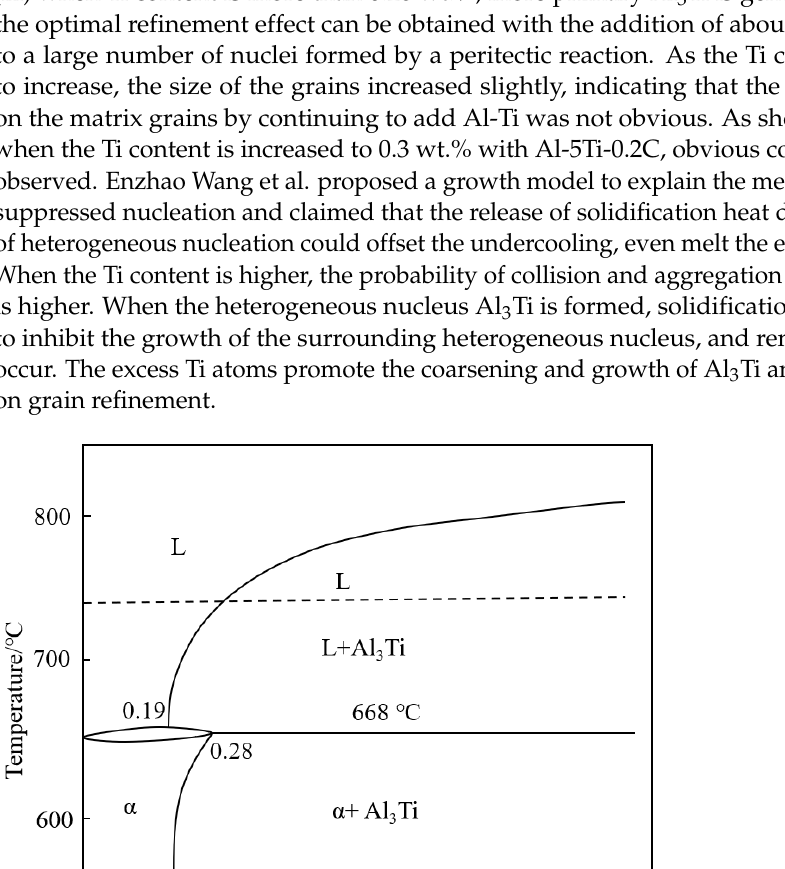
Table 3. The ultimate tensile strength (MPa) of alloy samples with different refiners.